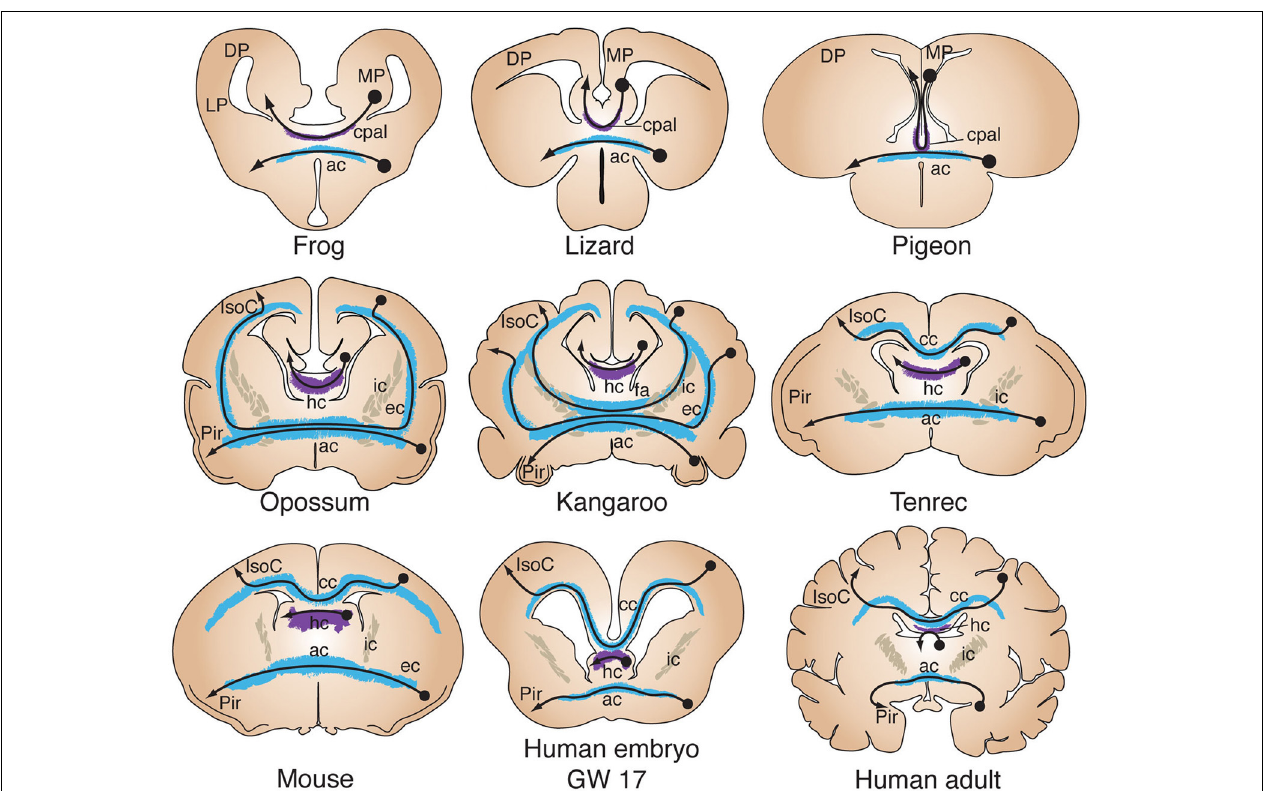
FIGURE 3 | Evolution of telencephalic commissures in tetrapods. Coronal schematics of tetrapod brains show the close association between the pallial commissure (cpal) and the anterior commissure (ac), bilaterally connecting the medial pallium (MP) and olfactory recipient structures, respectively. In the opossum all isocortical (IsoC) and piriform (Pir) commissural projections cross through the anterior commissure (ac) after coursing through the external capsule (ec). In the kangaroo, as in other diprotodont marsupials, axons from more dorsal regions of the isocortex course through the internal capsule (ic)